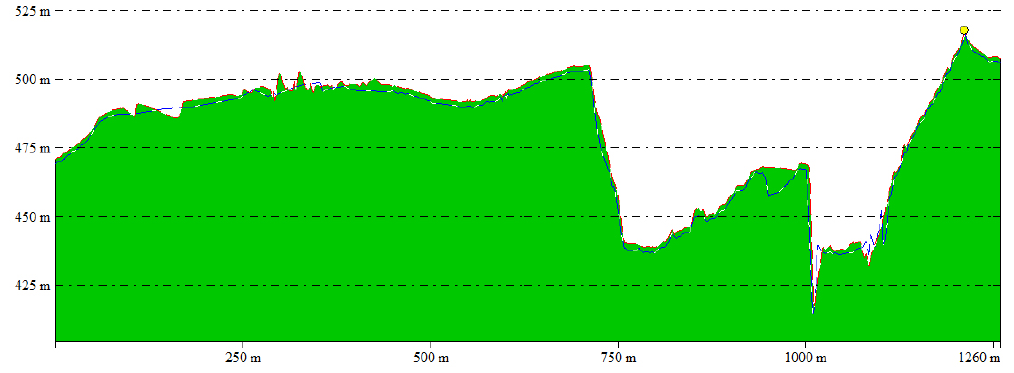
Figure 9. The profile of the two DEMs is reported. The red dashed line represents the DEM arising from the panchromatic image, while the blue dashed line represents the pansharpened